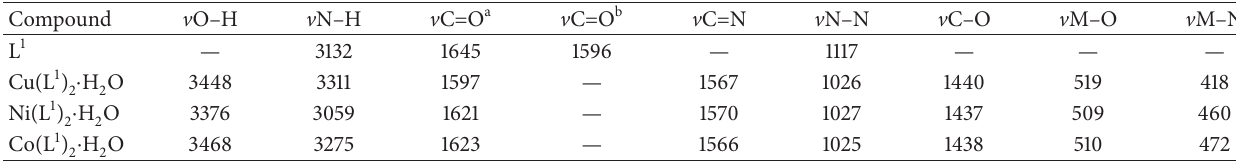
Table 4: Relevant IR absorption bands for the ligand and metal complexes.